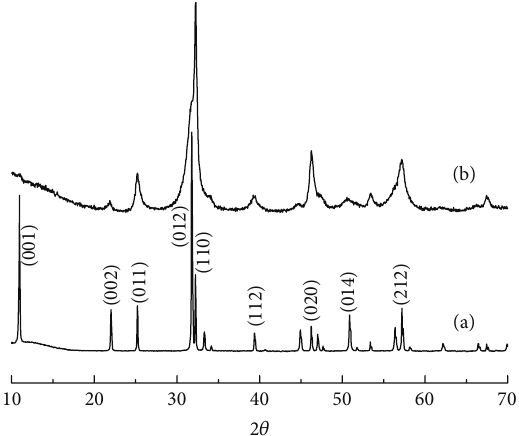
Figure 1: The XRD patterns of as-prepared BiOBr product samples. (a) BiOBr-SB; (b)